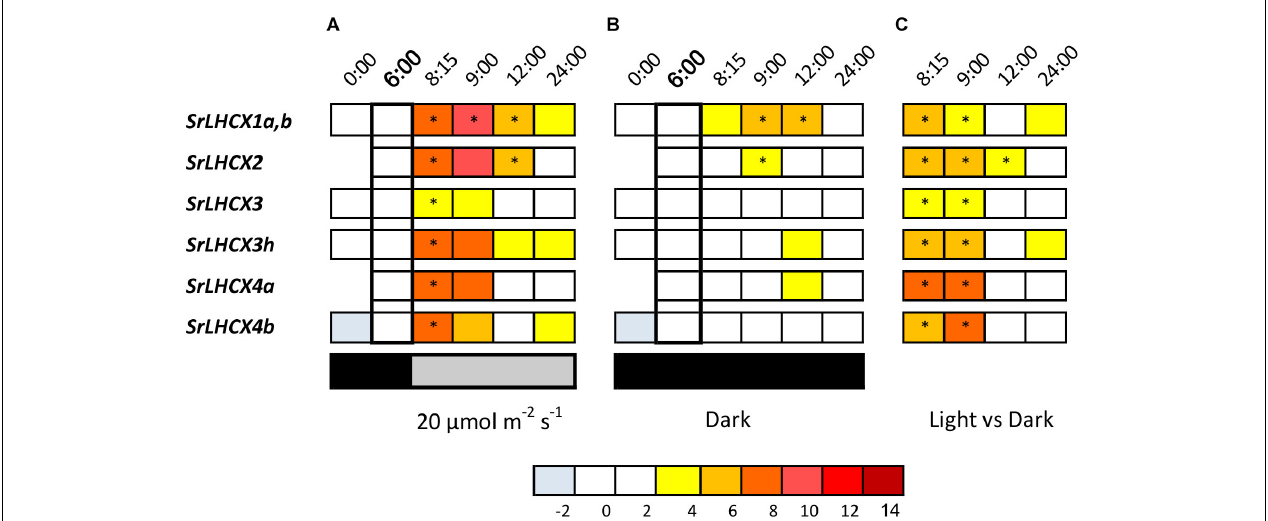
FIGURE 2 | LHCX transcription levels, compared to the 6:00 time point (in bold) during a 24-h 16/8 h day/night regime with light onset at 8:00 (A) , during extended darkness (B) and the transcript levels during the dark/light cycle compared to the extended dark period (C) . Expression ratios are log 2 transformed and values are indicated by the color chart. Values are averages of three independent biological replicates. As for SrLHCX2 and SrLHCX4a no transcripts were detected at (0:00) in some replicates, no values are shown. Significant changes ( p < 0.05, Pairwise Fixed Reallocation Randomization Test performed by REST2006) are indicated with an